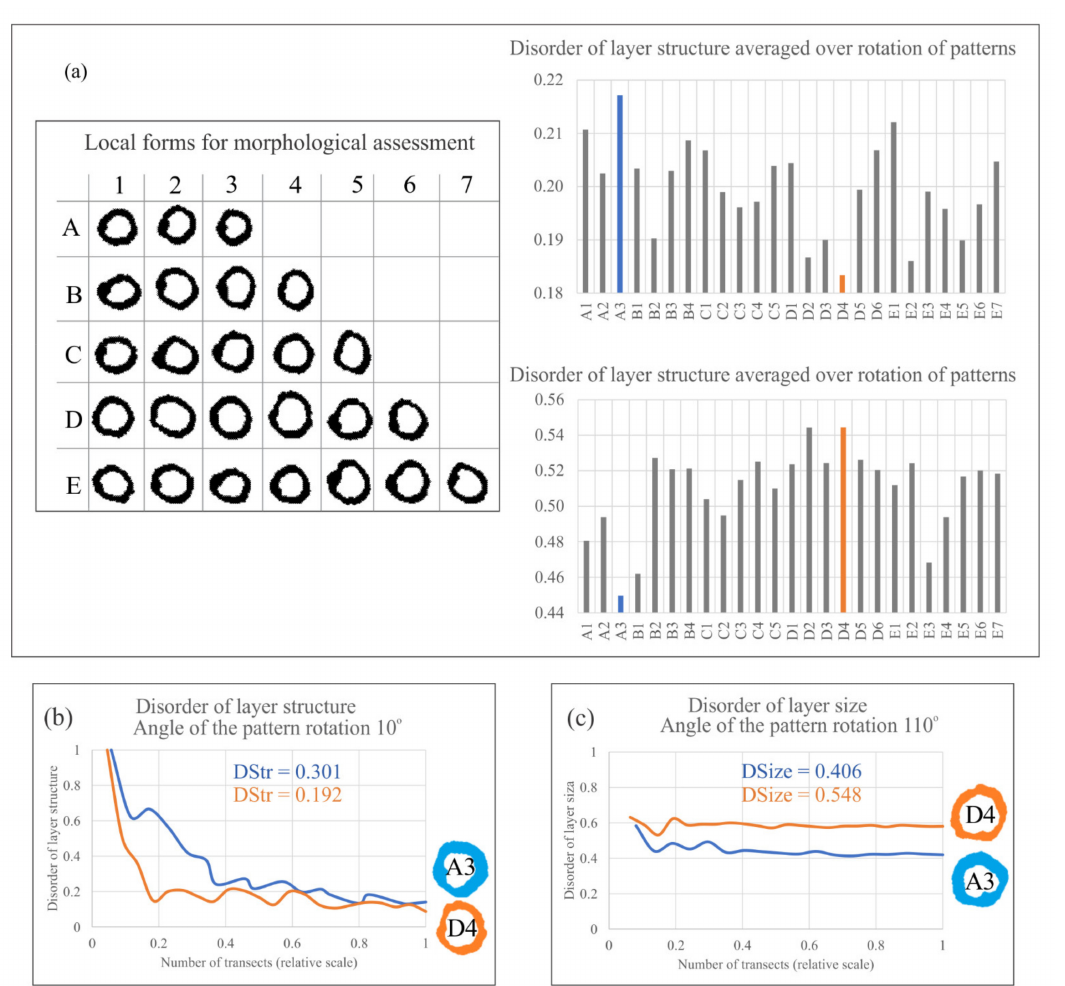
Figure 16. Morphological security code of the graphic drawing. ( a ) Morphology of 25 local shapes. ( b ) Two local shapes, A3 and D4, with maximal differences in the disorder of layer structure. ( c ) Two local shapes, A3 and D4, with maximal differences in the disorder of layer size.